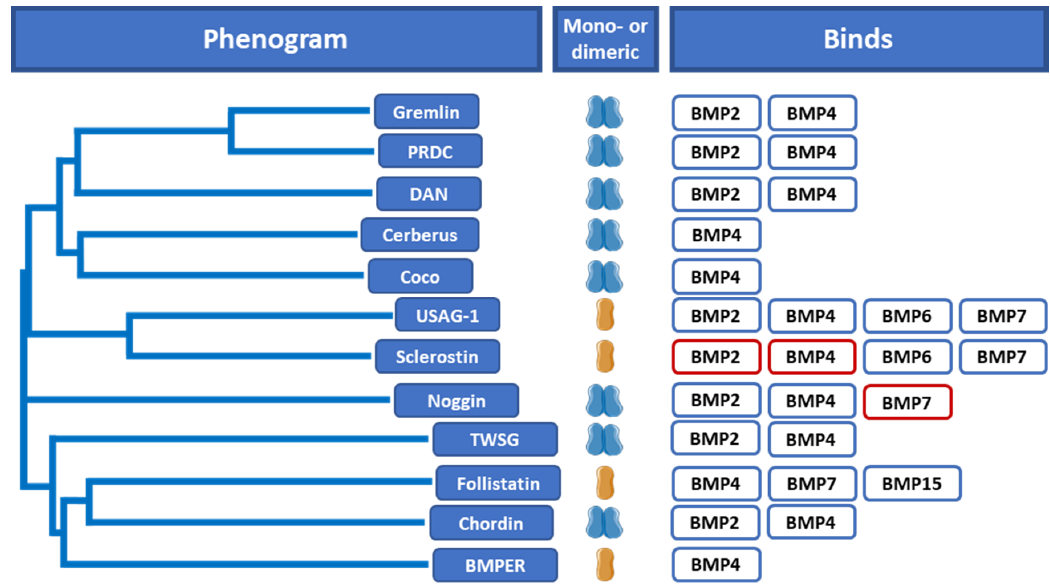
Figure 2. Based on the amino acid sequence, the antagonists do not share significant sequence similarities and the cystine-knots are considered to be the defining feature for most antagonists. While many of the antagonists form dimers, USAG-1, Sclerostin, Follistatin and BMPER are secreted as monomers. The different antagonists bind various BMP ligands. BMPs that have been reported to form weak interactions with an antagonist are shown in red. (This figure only shows the most well-known and studied antagonists).